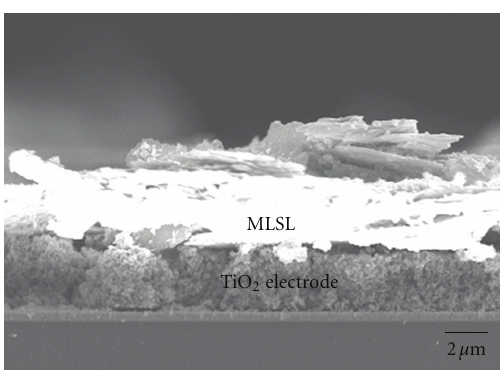
Figure 1: FE-SEM image of TiO 2 electrode withMLSL.